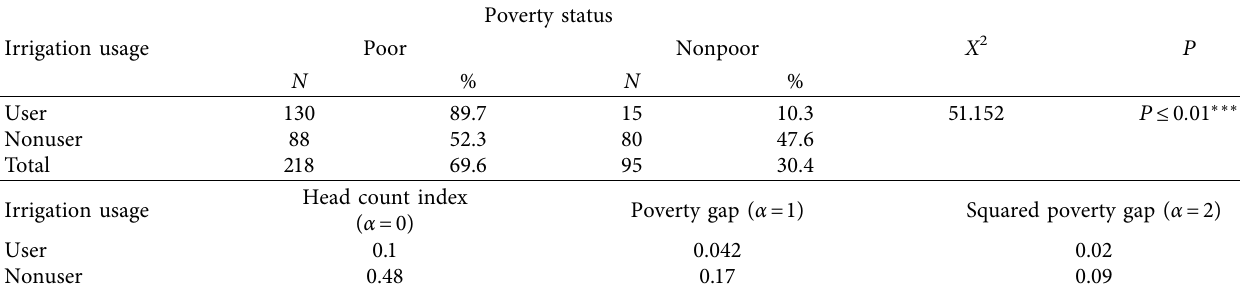
Table 9: Poverty status and indices by access to irrigation